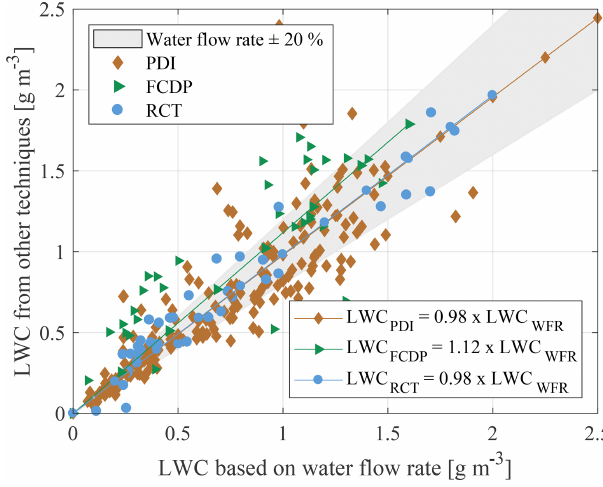
Figure 12. Comparison of number concentrations of PDI and FCDP. Figure 13. Intercomparison of LWC based on the water flow rate and measured with the PDI, the FCDP and the